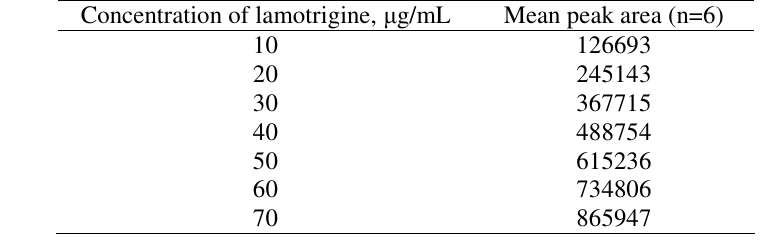
Table 1. Calibration of the proposed method